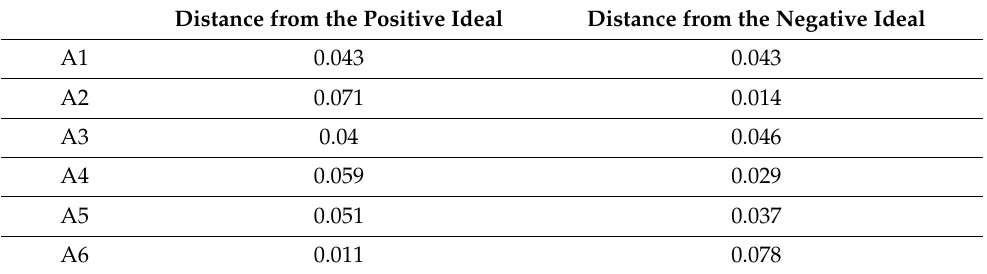
Table 8. Distance from positive and negative ideal solutions.